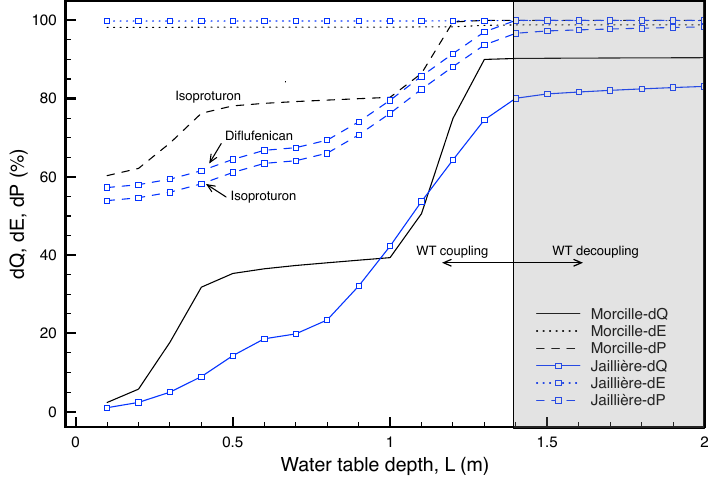
Figure 5. Change in d Q (reduction of surface water), d E (reduction of sediment), and d P (reduction of pesticide isoproturon) with water table depth for experimental events in Fig. 4a–b. Gray area indicates water table depths where influence over surface outputs on the VFS is no longer